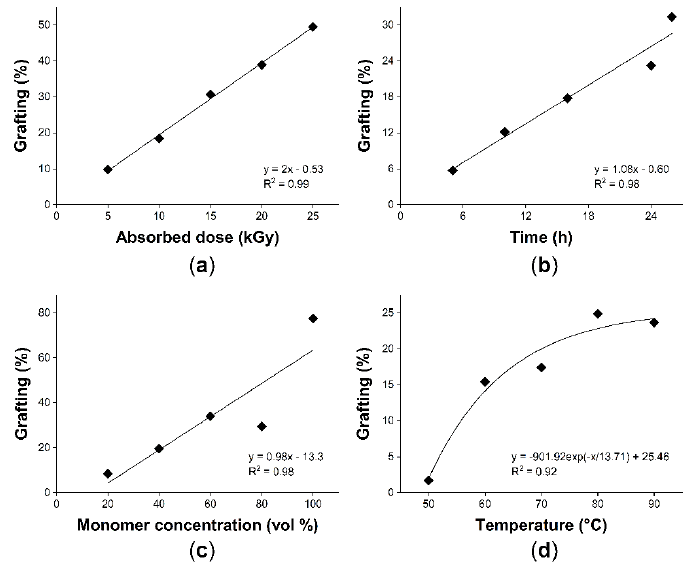
Figure 1. Grafting of MMA onto pristine PP: ( a ) Effect of absorbed dose (16 h, 65 °C, MMA 20 vol%); ( b ) reaction time (5 kGy, 65 °C, MMA 30 vol%); ( c ) monomer concentration (15 kGy, 16 h, 70 °C), and ( d ) reaction temperature (5 kGy, 16 h, MMA 30 vol%).